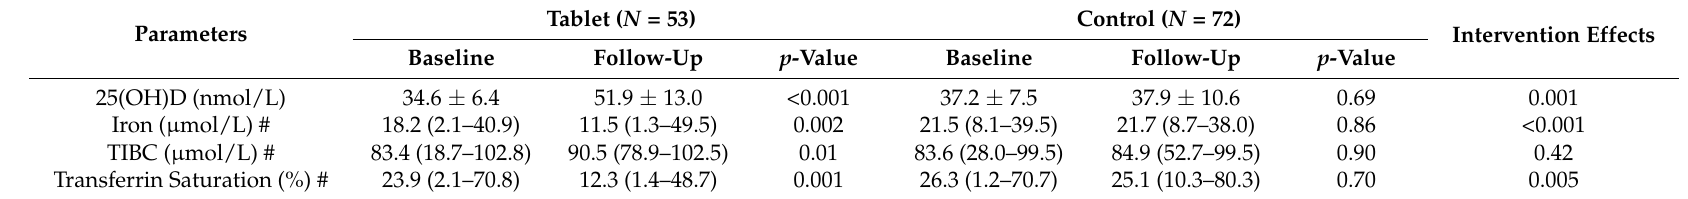
Table 3. Changes in vitamin D and iron indices at baseline and